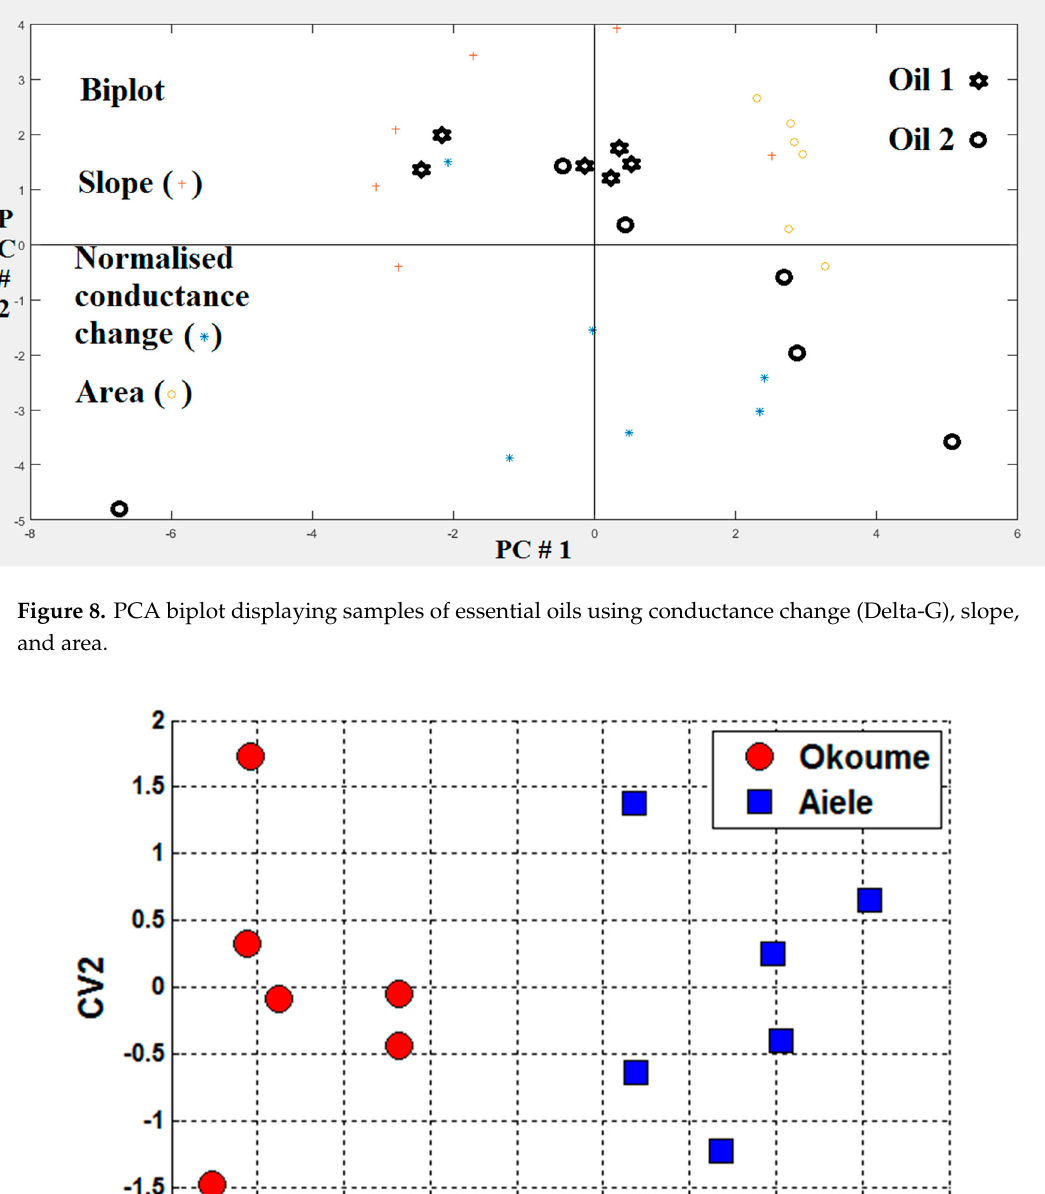
Figure 8. PCA biplot displaying samples of essential oils using conductance change (Delta-G), slope,